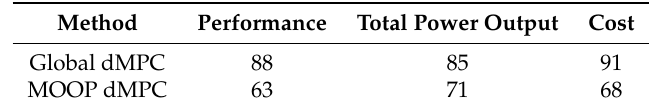
Table 1. Normalized units in percent for variable wind speed conditions. Distributed MPC (dMPC),